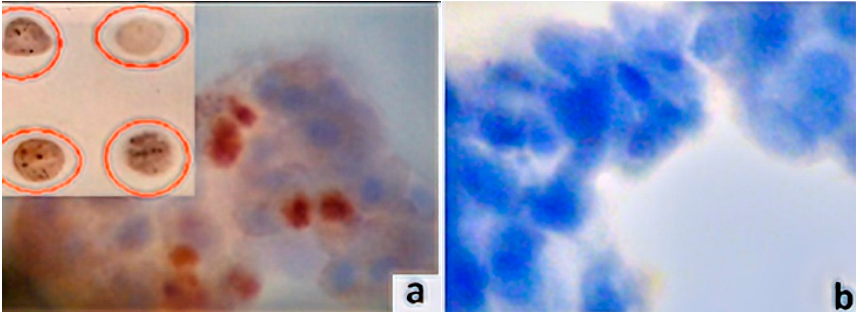
Figure 2. FGF-2 protein expression patterns in pterygia fibro-endothelial cells (original magnification 400×). ( a ) FGF-2 high expression in a cell spot. Note dark brown nuclear/perinuclear staining pattern. Inset image: cell spot arrays. Spots were obtained by scraping liquid-based cytological specimens (3-3, diaminobenzidine tetrahydrochloride (DAB) chromogen). ( b ) FGF-2 negative stain. Note absence of the marker’s expression (control); counterstained with hematoxylin.